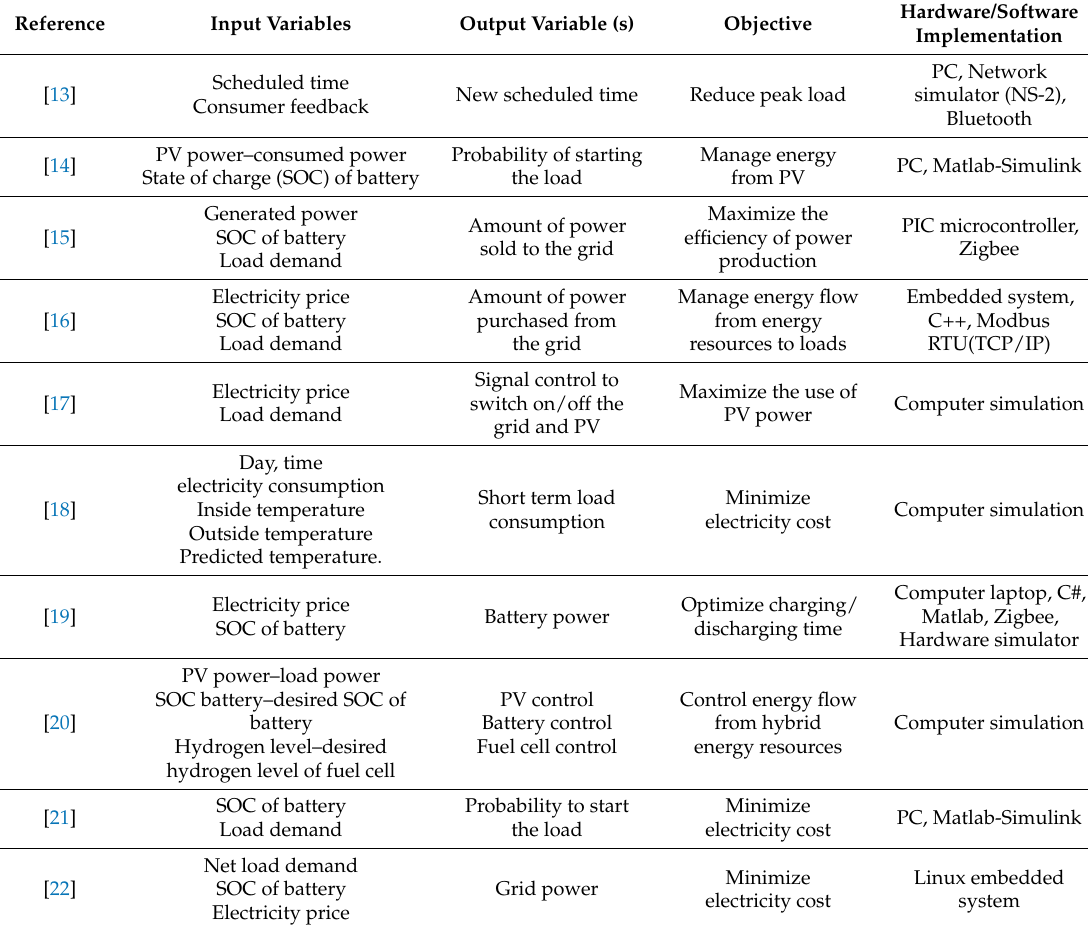
Table 1. Summary of previous works of the FLC-based